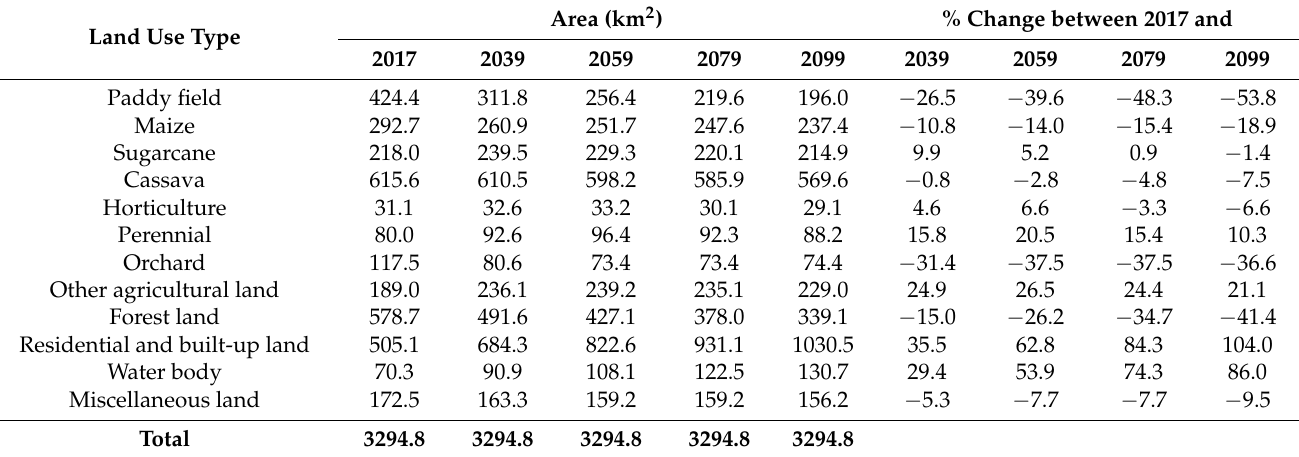
Table 3. Land use change analysis for every twenty years from 2039 to 2099 compared to 2017.